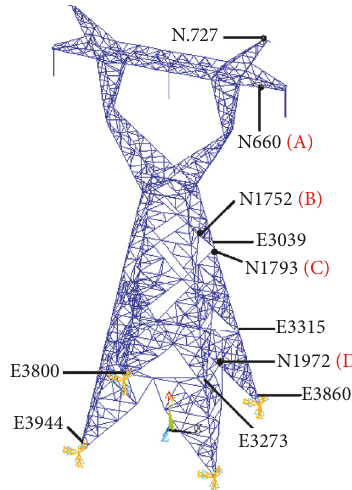
Figure 15: Measuring locations of the nodes and elements on trans- mission tower number 160.